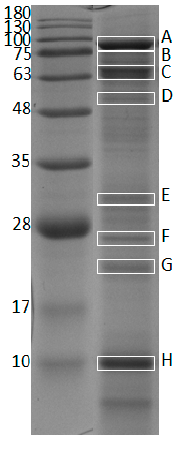
Figure 1. Twelve percent SDS-PAGE of dried giant grouper roe. Lane 1 : standard protein markers; Lane 2 : dried giant grouper roe.